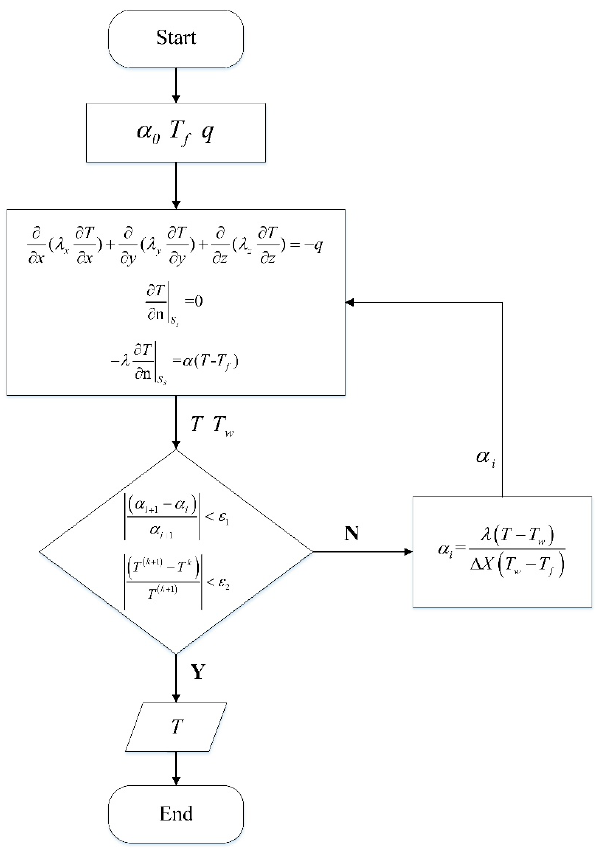
Figure 15. The chart of the iterative method.